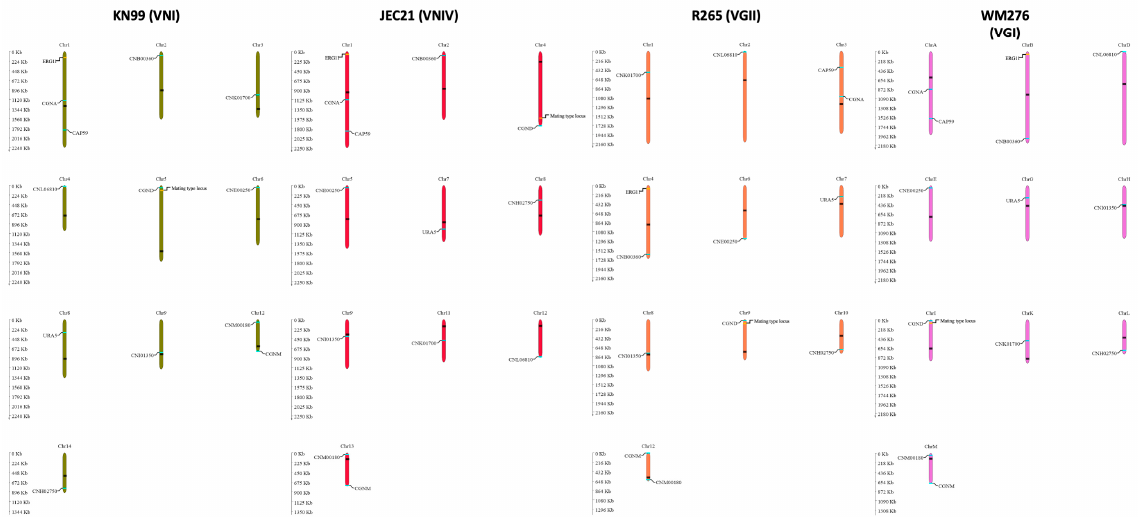
Figure 1. Chromosomal locations of the fourteen polymerase chain reaction-restriction length polymorphism (PCR-RFLP) markers that were used for progeny genotyping in this study. These markers were located across 10 chromosomes (out of 14) on the four reference genomes of strains, KN99 (VNI lineage), JEC21 (VNIV lineage), R265 (VGII lineage), and WM276 (VGI lineage). Dark text indicates the location of